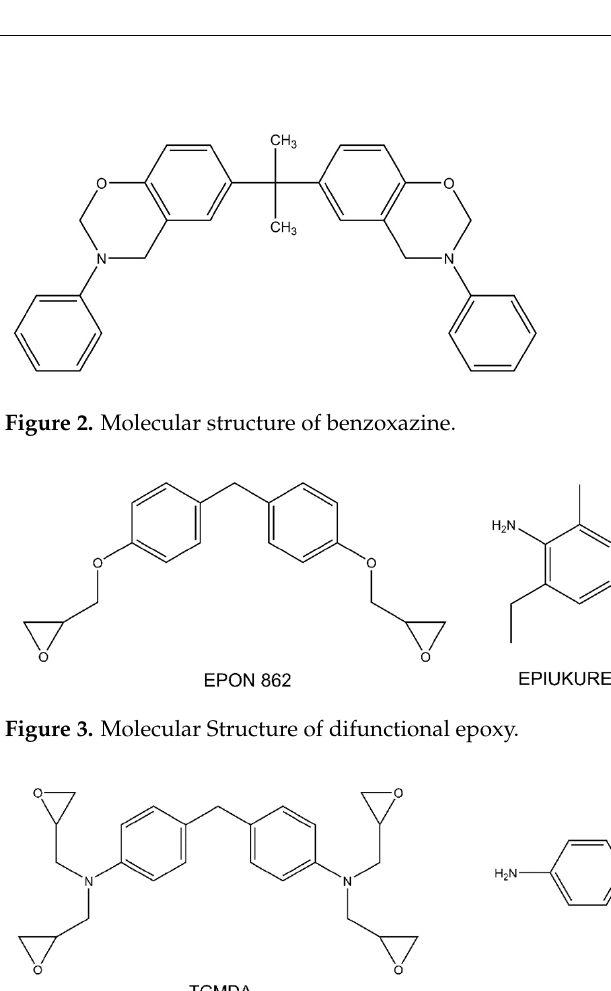
Figure 1. Molecular structure of BMI.